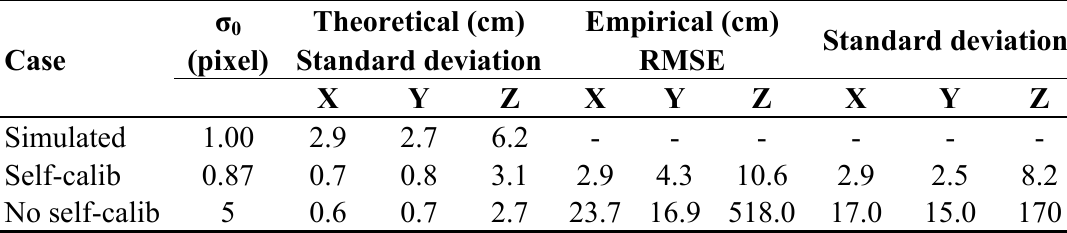
Table 3. Point determination accuracy estimates. The adjustment cases are the simulated case and the empirical evaluations with self-calibration (Self-calib) and without self-calibration (No